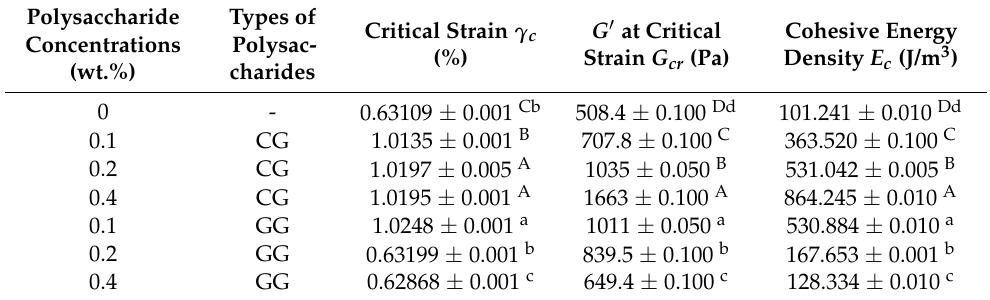
Table 2. Critical strain ( γ c ), G (cid:48) at critical strain ( G cr ), and cohesive energy density ( E c ) of PC-CG and PC-GG gels at various polysaccharide